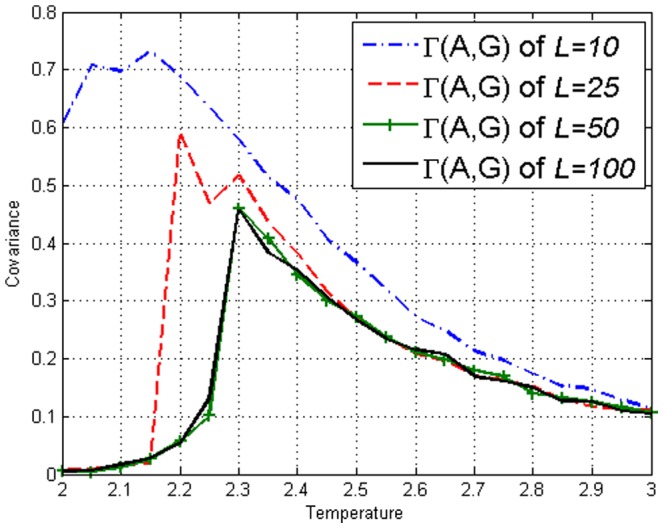
Covariance  on the Ising model with lengths L=10,25,50,100 obtained using equation (10).